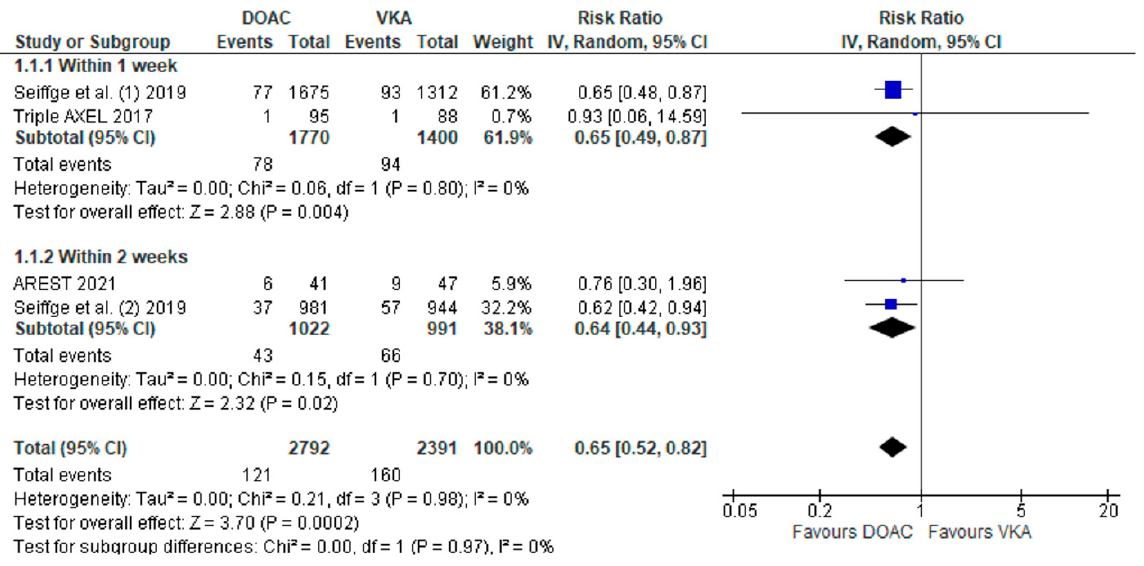
Figure 2. Forest plot presenting the risk ratio of recurrent IS among patients treated with DOACs versus VKAs, stratified by the timing of treatment initiation [10,11,23].